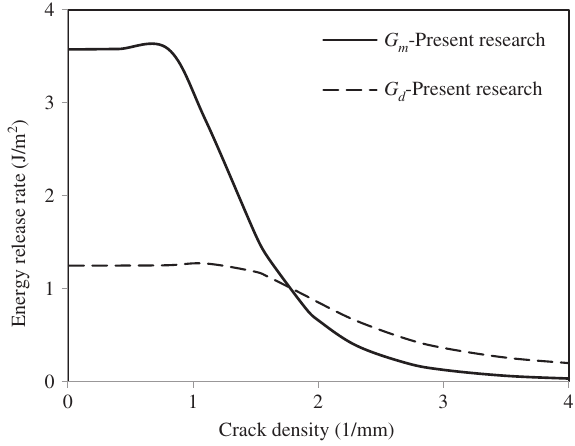
Figure 6: Crack density vs. energy release rate for [0/90] s carbon/ = 100 epoxy laminate under σ 1